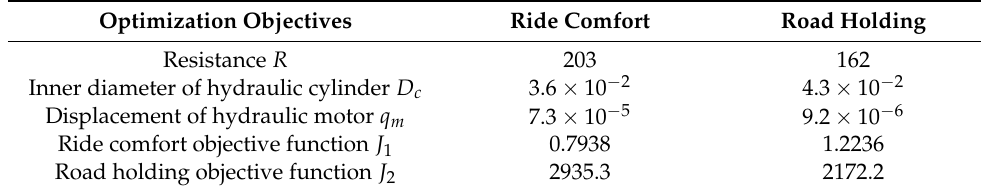
Table 7. Comparison of two optimized HIIRS.